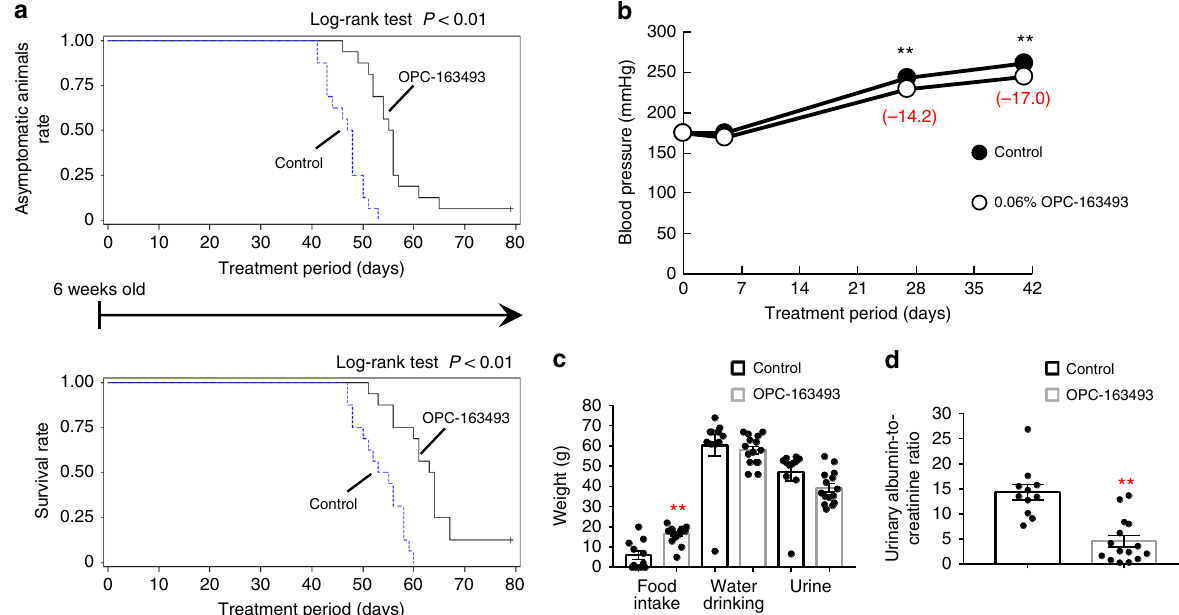
Fig. 8 Effects of OPC-163493 in salt-loaded male SHRSPs. a Survival rates and rates for asymptomatic animals. Initial animal numbers of both groups are 16. Salt loading (1% sodium chloride in drinking water) and treatment (0.06% OPC-163493 mixed chow or control chow) commenced on the same day (day 0) in the animals at the age of 6 weeks. Signi fi cant delays were observed for both stroke onset (debility, convulsion, tremor, paralysis, rigors,